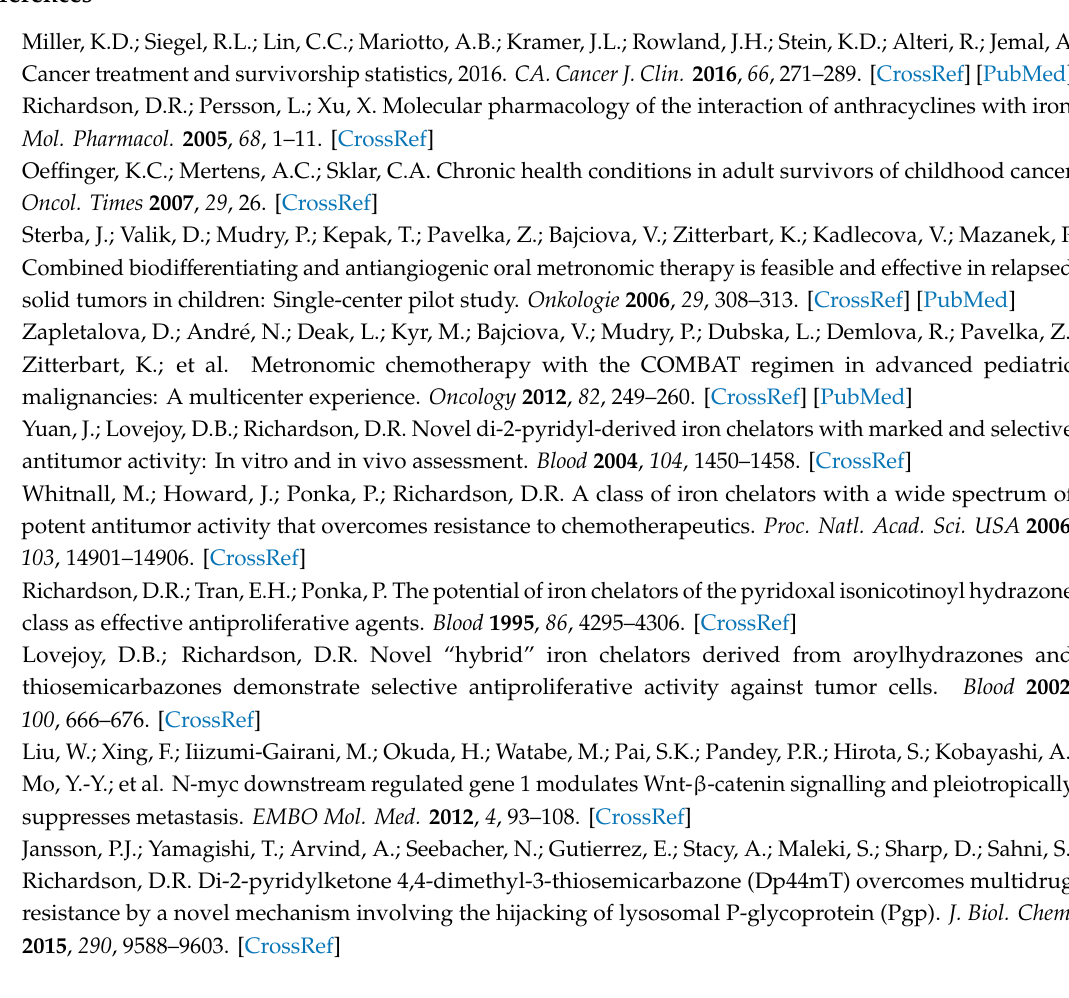
Figure S1: COX-2 levels in untreated cell lines and after the treatment with thiosemicarbazones, Figure S2: NDRG1 levels in untreated cell lines and after the treatment with thiosemicarbazones, Figure S3: p-AKT and AKT levels after the treatment with IC50 doses of CX, DpC, Dp44mT and their combinations, Figure S4: MGMT levels in untreated cell lines and after the treatment with thiosemicarbazones, Figure S5: Levels of mismatch repair proteins in untreated cell lines and after the treatment with thiosemicarbazones, Figure S6: TOP2 α levels in untreated cell lines and after the treatment with